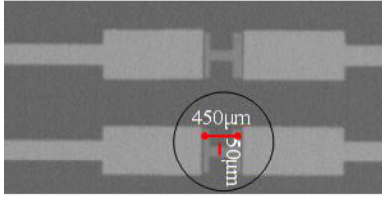
Figure 7. Preparation process of pH-sensitive ion-sensitive field-effect transistor (ISFET).